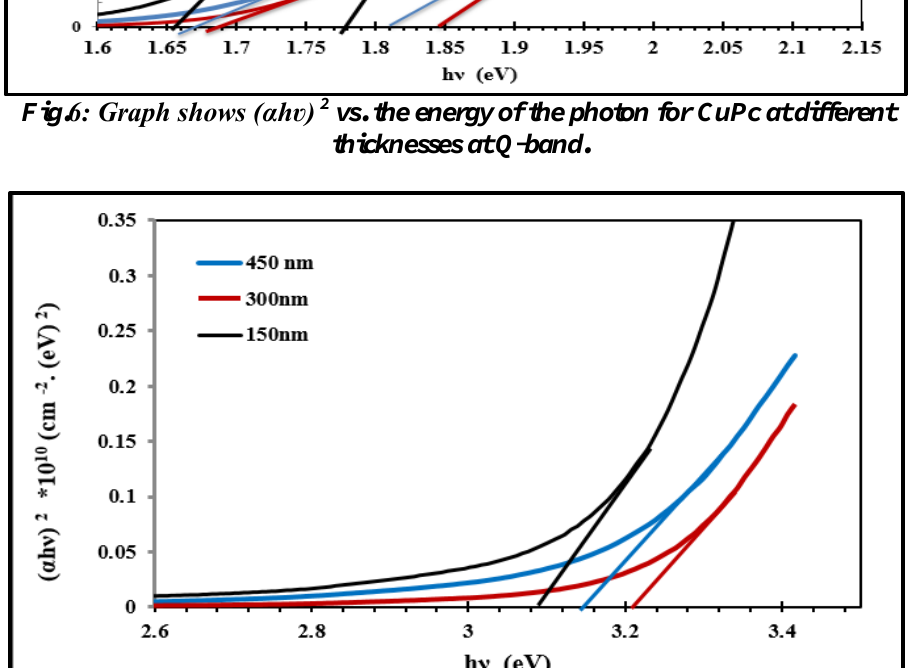
Fig.7: Graph shows (αhʋ) 2 vs. the energy of the photon for CuPc at different thicknesses at